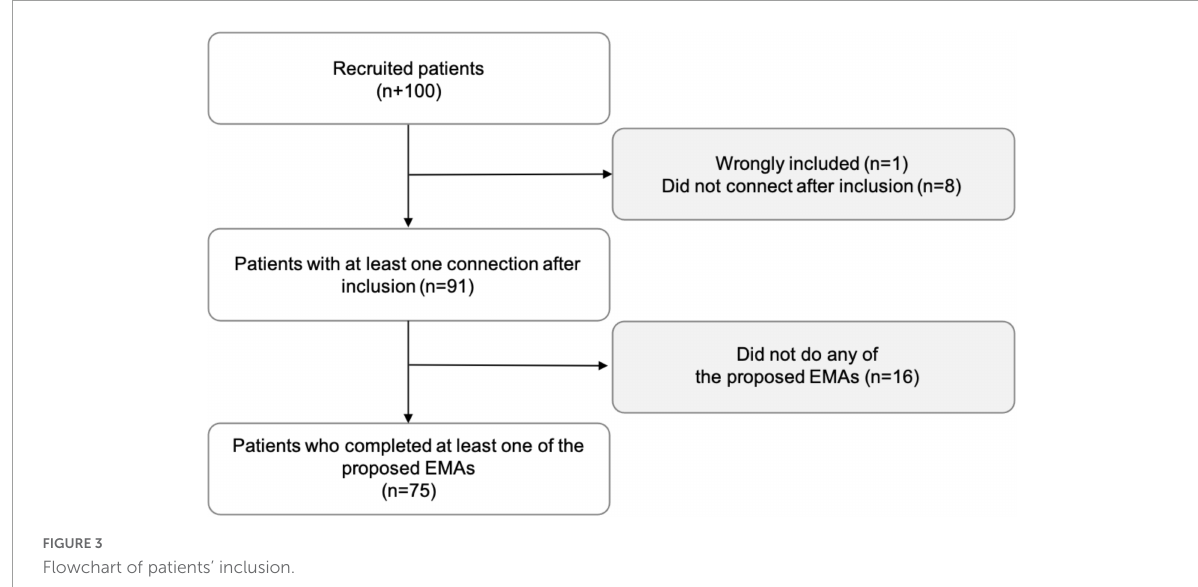
FIGURE3 Flowchart of patients’ inclusion.